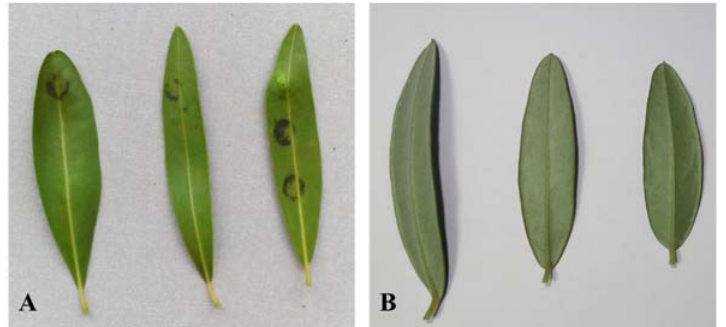
Figure 1. Olive leaf spot (OLS) lesions appeared on olive leaves after immersion in sodium hydroxide. ( A ) Leaves from control plants. ( B ) Leaves from laminarin ‐ treated plants.